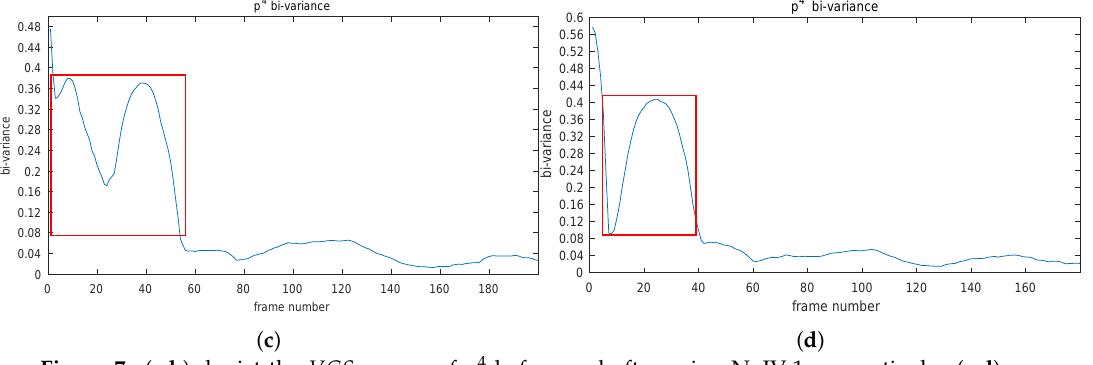
Figure 7. ( a , b ) depict the VCS curves of p 4 before and after using NoIV-1, respectively. ( c , d ) are the bi-variances of p 4 before and after using NoIV-1, respectively. Red rectangles emphasize the obvious